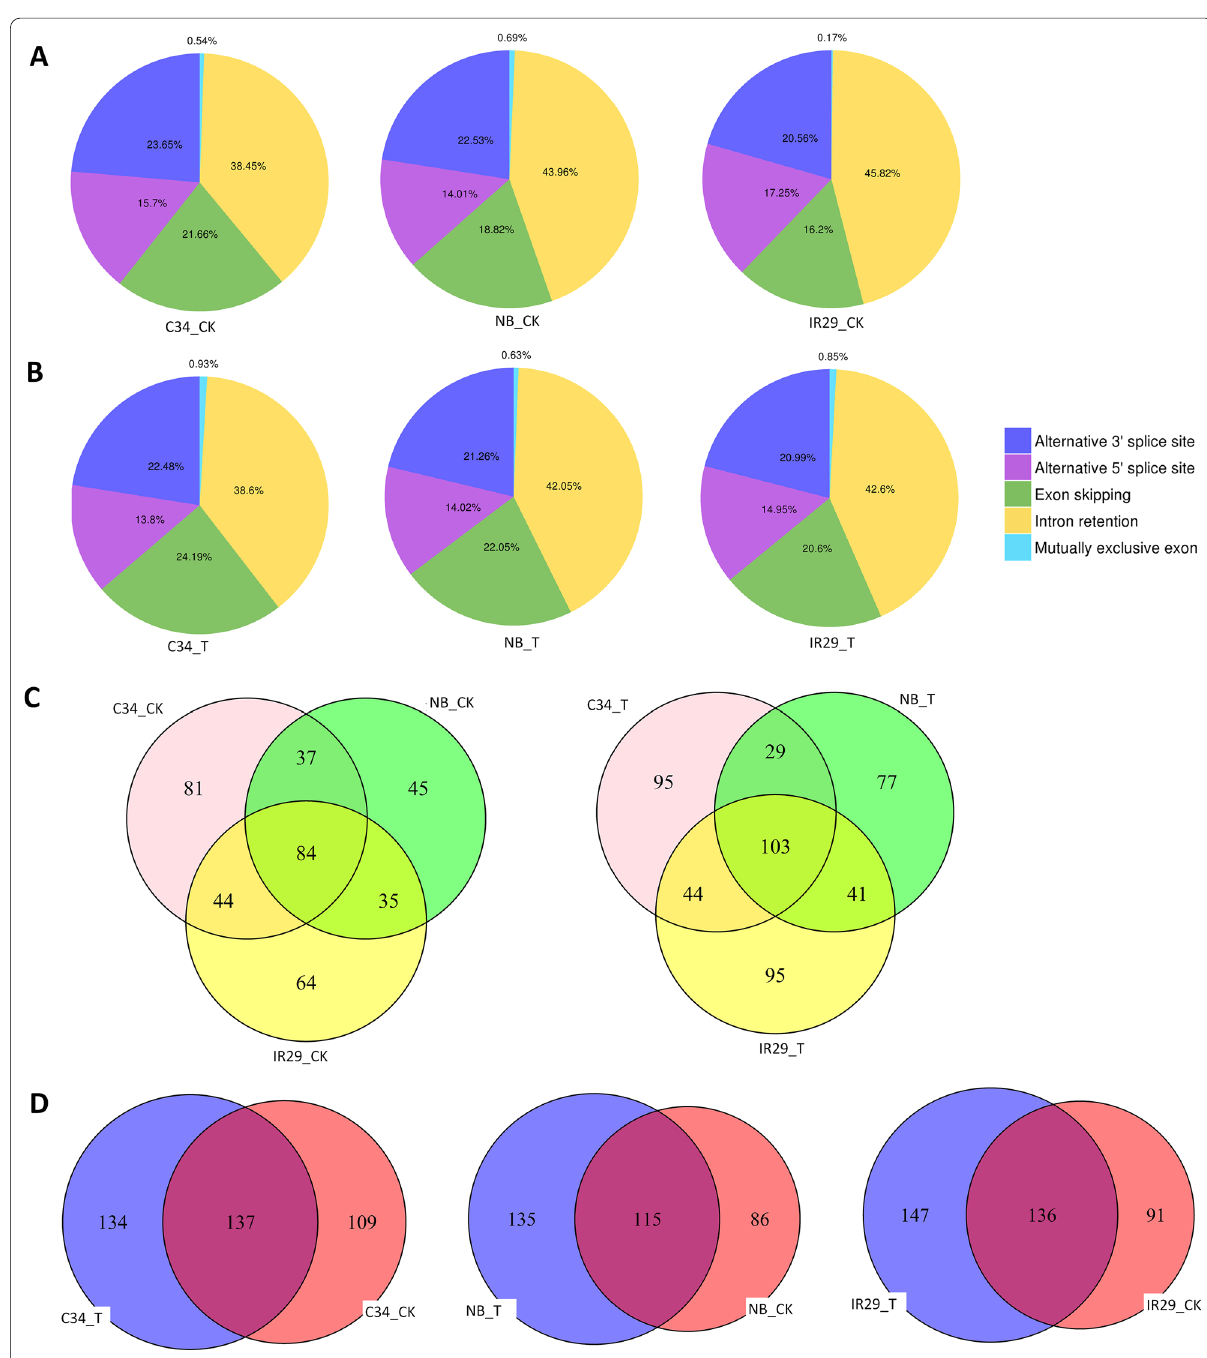
Fig. 7 mRNA alternative splicing regulation in different rice varieties. A . Percentages of AS events in different rice varieties under normal conditions. B . Percentages of AS events in different rice varieties under salt stress conditions. C . Numbers of common and variety-specific Alternative spliced genes between different rice varieties under control conditions (left) and salt stress conditions (right). D . Numbers of alternative spliced genes in different rice varieties before and after salt